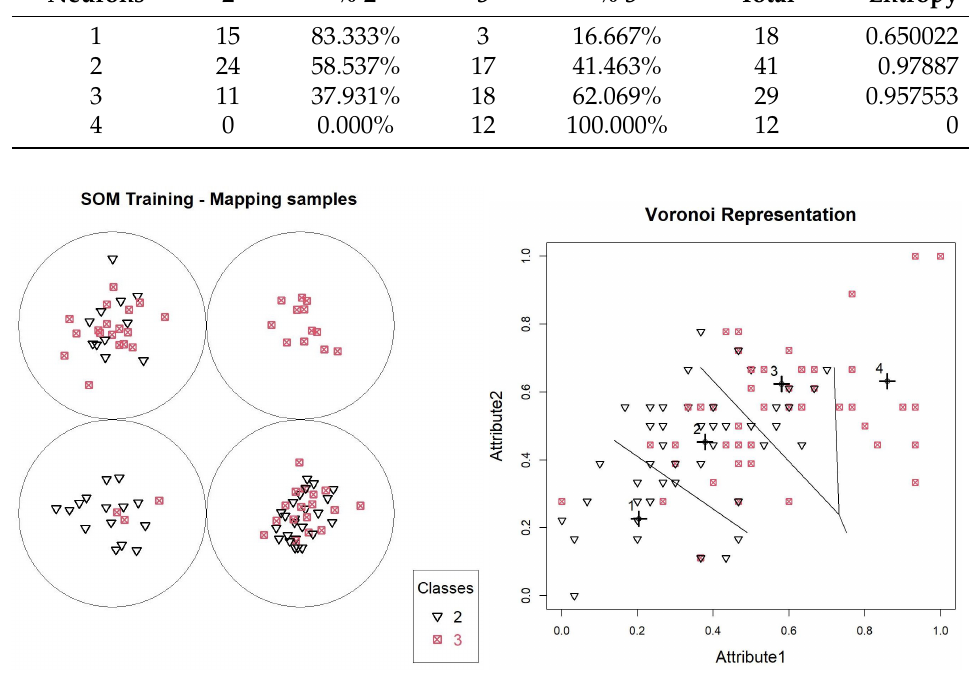
Figure 4. Object overlap per neuron and Voronoi representation—Synthetic